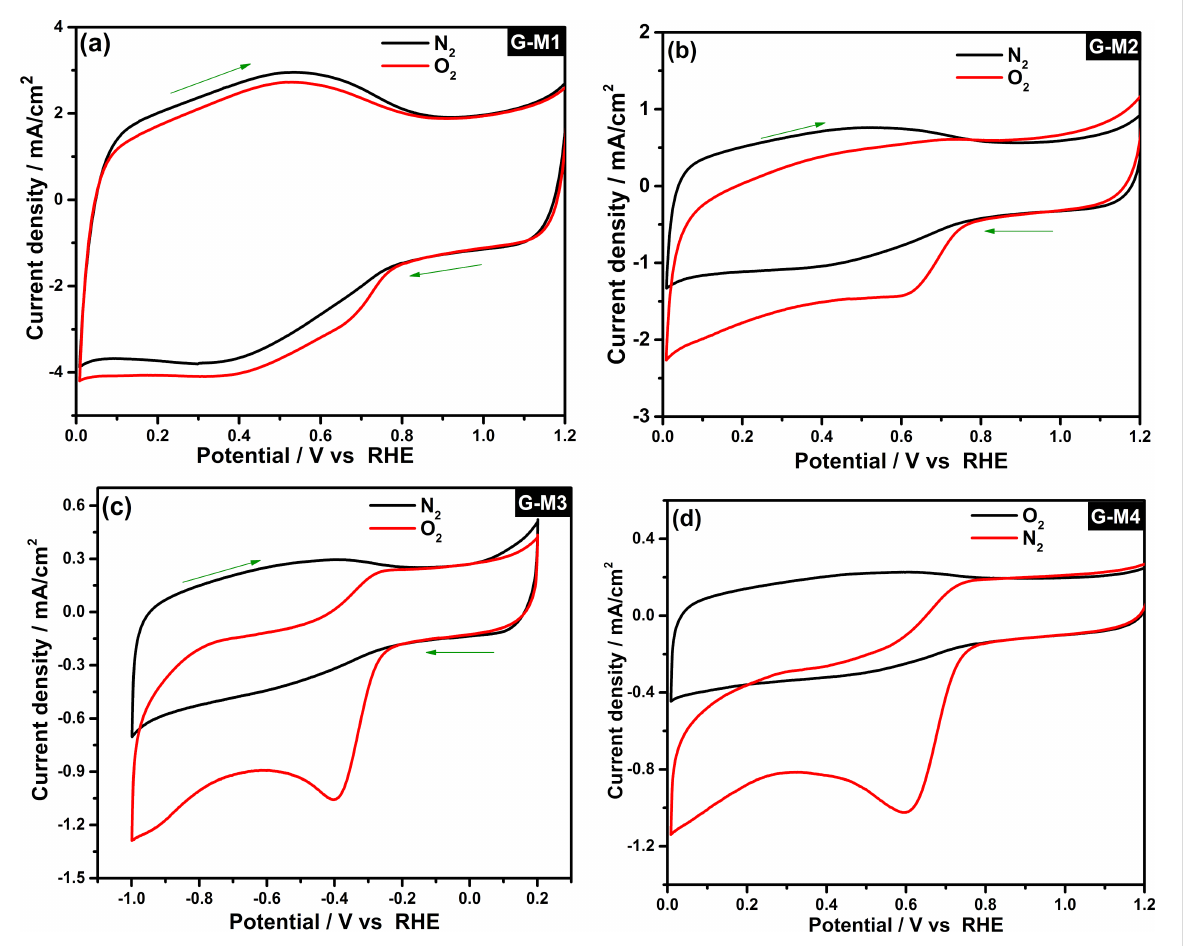
Figure 3: The CV profiles of different electrodes in 0.1 M KOH electrolyte saturated with N 2 and O 2 . The current density is calculated using the geometrical surface area.